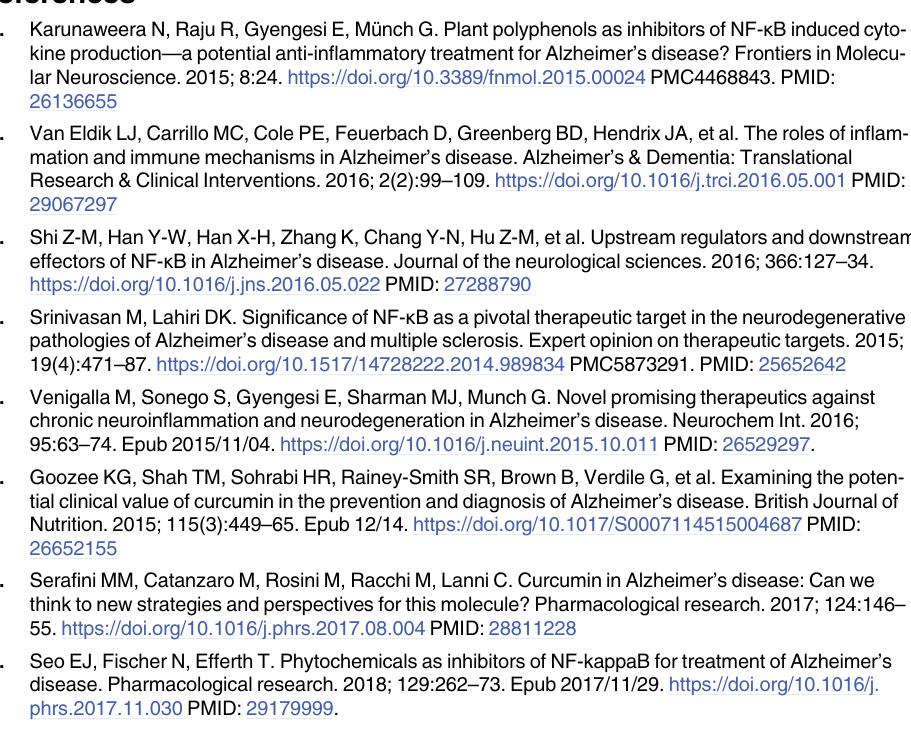
S2 Fig. Ambrosin chemical structure and important HMBC correlations. S1 Table. Chemical shifts of 1H-NMR and 13C-NMR of